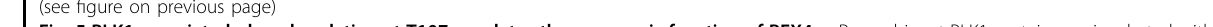
Fig. 5 PLK1-associated phosphorylation at T107 regulates the oncogenic function of BEX4. a Recombinant PLK1 protein was incubated with bead-bound GST, GST-BEX4 WT, or GST-BEX4 T107A mutant in the presence of ATP. Mixtures were immunoblotted with the indicated antibodies. Coomassie-stained gel is shown for GST, GST-BEX4 WT, and GST-BEX4 T107A mutant proteins. Arrowheads indicate GST, GST-BEX4 WT, and GST-BEX4 T107A. b HeLa cells were transfected with GFP-, GFP-BEX4 WT-, or GFP-BEX4 T107A-expressing plasmids. Each sample was immunoblotted with the indicated antibodies. c HeLa cells expressing GFP, GFP-BEX4 WT, or GFP-BEX4 T107A were treated with nocodazole (300ng/ml). After 36 h, the cells were harvested and stained with propidium iodide. DNA contents were analyzed by fl ow cytometry. d Histograms summarizing the distribution of different DNA contents in the cells analyzed in ( c ). The results are the mean ± SEMs of three independent experiments. * P <0.05, ** P <0.01, *** P <0.001. e HeLa cells, two non-tumor cell lines [amniocyte and adipose-derived mesenchymal stem cells (AD-MSCs)] and 11 lung cancer cell lines (WI-26, H1299, Calu-3, HCC1171, HCC1833, HCC2108, SK-LU-1, A549, HCC95, SK-MES-1, and SW900) were lysed and immunoblotted with anti-BEX4, anti-CDK1, anti-PLK1, and anti-actin antibodies. f A model of the functions of BEX4 during mitosis. Refer to the Discussion section for